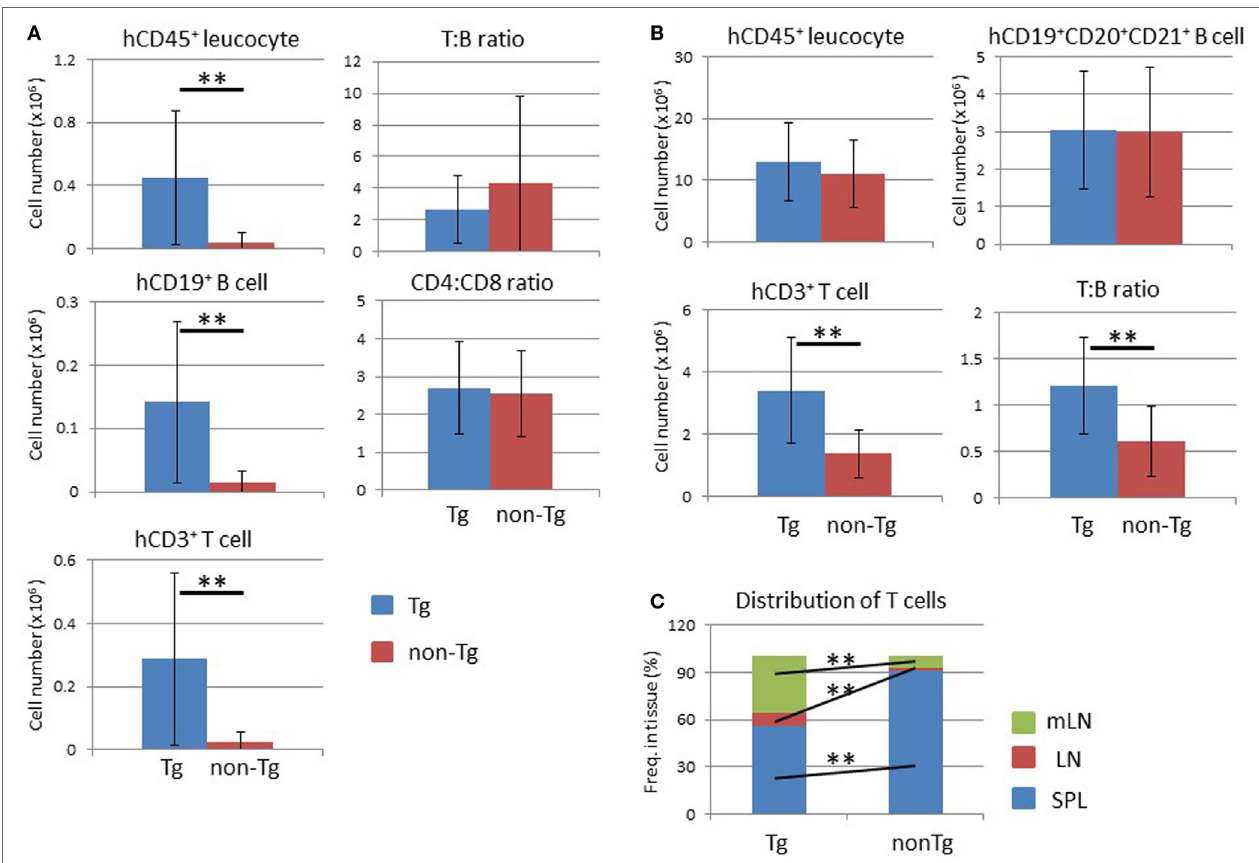
FigUre 8 | Analysis of lymph nodes (LNs) and distribution of human T lymphocytes. (a) Absolute number of human leukocytes in tissue-associated LNs. Human mononuclear cells were prepared from pooled LNs from NOG-pROR γ t- γ c Tg and NOG non-Tg mice at 24 weeks after hematopoietic stem cell transplantation. (Left panels) Numbers of human CD45 + leukocytes (upper), human B cells (middle), and human T cells (bottom) were calculated by multiplying the total number of mononuclear cells by the frequency of each fraction. (Right panels) The human T to B cell ratio (upper panel) and human CD4 + T cell to CD8 + T cell ratio (bottom panel). (B) Total number of human leukocytes in secondary lymphoid organs. Data from the spleen, LNs, and mesenteric LNs were summed for human CD45 + leukocytes (upper left), human B cells (upper right), and human T cells (bottom left). The human T to B cell ratio in all lymphoid organs is also shown (bottom right). (c) Distribution of human T cells. The proportion of human T cells in each secondary lymphoid organ was calculated. Mean ± SD from NOG-pROR γ t- γ c Tg ( n = 12) and NOG non-Tg mice ( n = 11). Statistical significance was evaluated by Student’s t -test (** p <